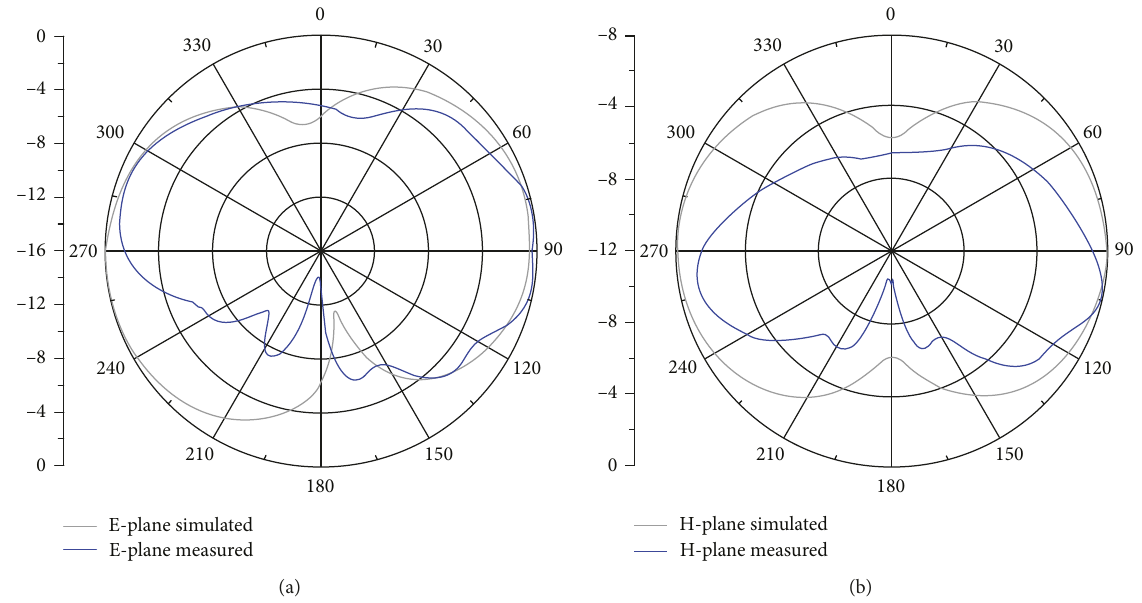
Figure 7: Radiation pattern simulation and experimental results of the SSO optimized Koch fractal antenna at